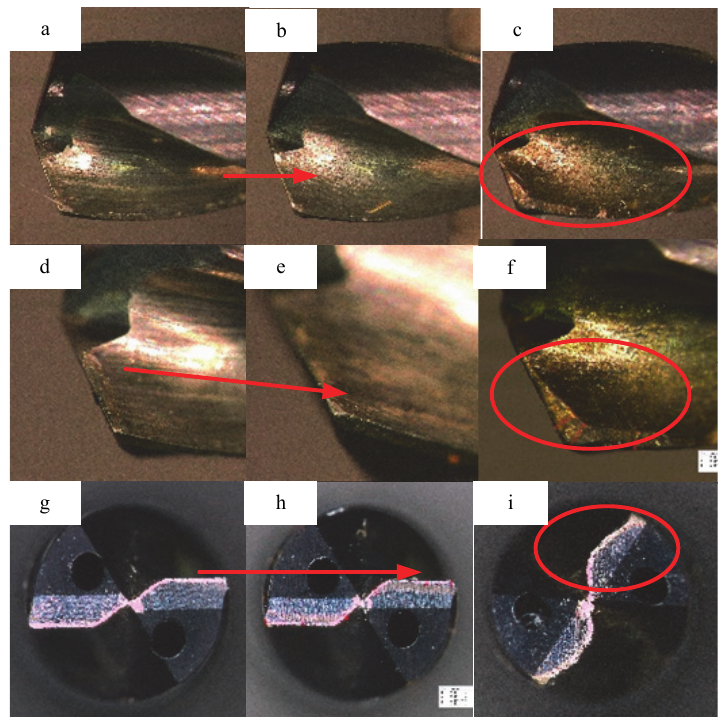
Figure 2. The high temperature generated by the edge causes the cutting bit to change color (( a , d , g ) are new tools after single drill holes; ( b , e , h ) are the tools after approximately 10 holes were drilled on average; and ( c , f , i ) are the wear conditions after drilling 30 holes) [18].